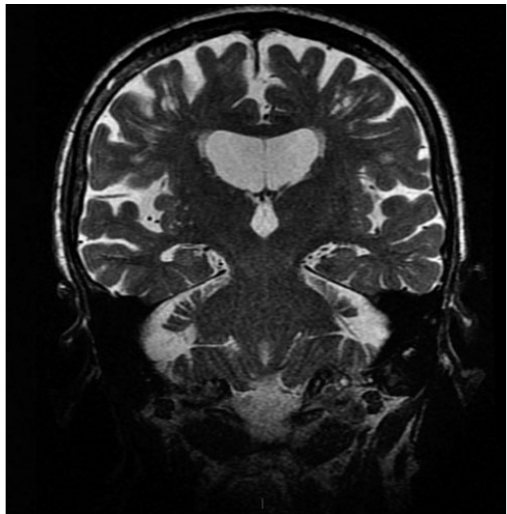
Figure 1. MRI with difuse cortical atrophy, frontal predominance.